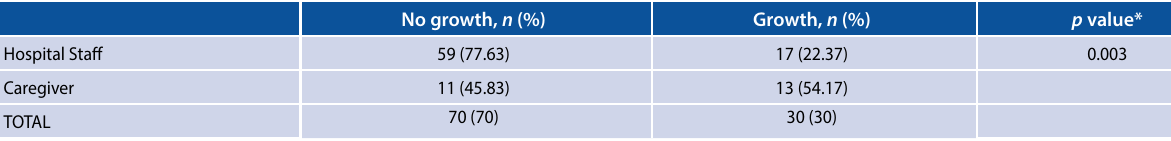
*Statistical analyses were performed using STATA version 11.1 (Mac). Table 2: Bacterial growth stratified according to ward